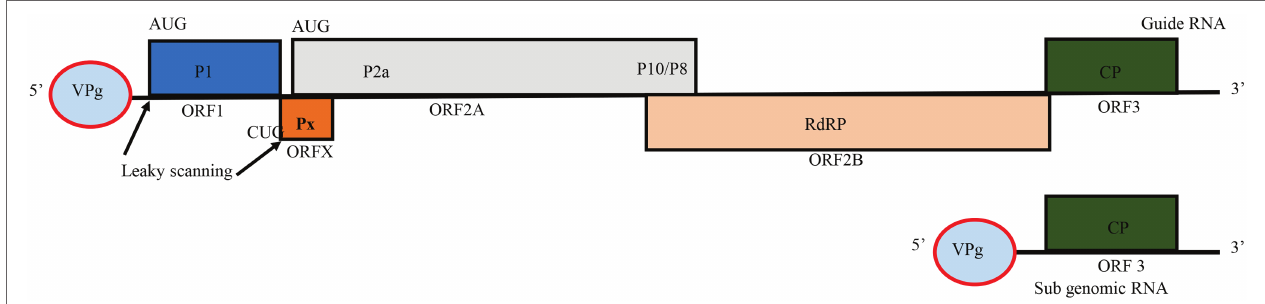
FIGURE 1 | Genome organization of Rice yellow mottle virus (RYMV). Boxes represent open reading frames (ORFs) and the encoded proteins in each ORF. VPg, viral genome-linked protein; P1, gene silencing suppressor protein; P2a, viral protease; P10/P8, polyproteins with no assigned function; RdRP, RNA dependent RNA polymerase; CP, major coat protein. The figure was adapted from Ling et al.